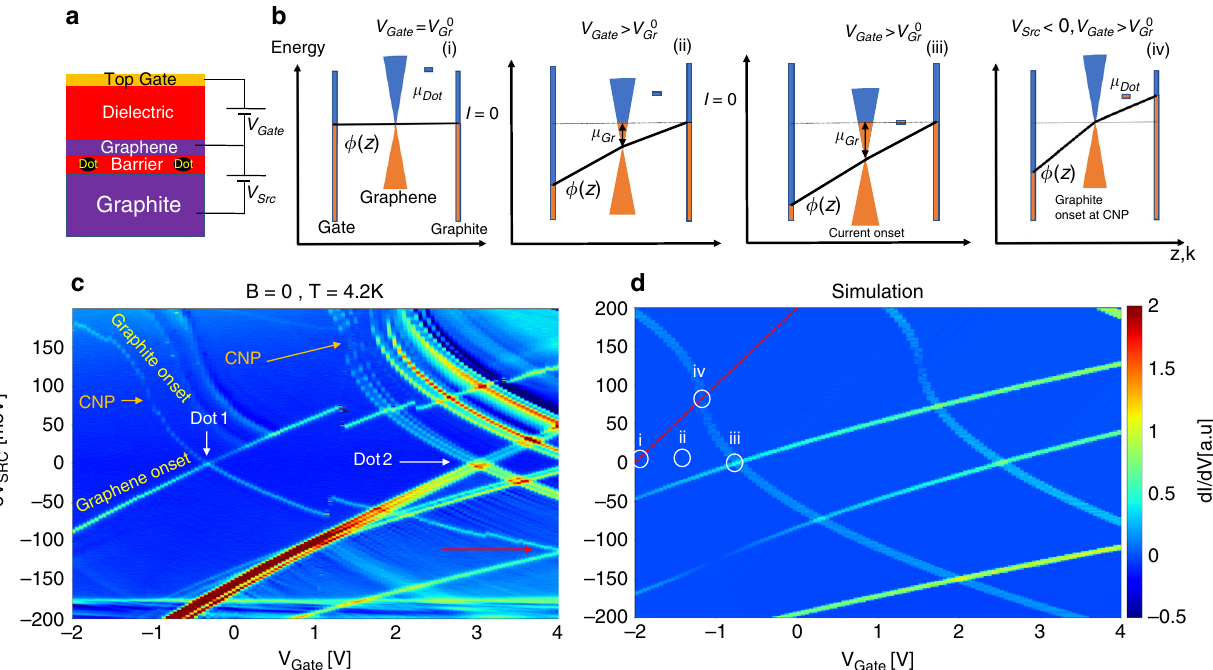
Fig. 1 Tunneling through quantum dots. a A schematic illustration of the device. The quantum dots are present within the hBN layer between graphite and graphene. b The energy diagram illustrating the change of the electrostatic potential ϕ ( z ) upon application of V Gate and V Src and its effect on the dot potential μ Dot . The horizontal axis marks both k (momentum of the graphene dispersion) and z (the position coordinate). c d I /d V vs. − e V S rc and V Gate at T = 4.2 K. Transport signatures of distinct quantum dots, “ Dot 1 ” and “ Dot 2 ” are marked. CNP is marked by an arrow for both dots. Graphite (source) onset and graphene (drain) onset lines are labeled for Dot 1 while the red arrow signals the charging energy of Dot 1. d Simulated d I /d V for the capacitive model described in the text, assuming two dots where μ 0 = 40 meV for Dot 1 and μ 0 = 67 meV for Dot 2. The positions corresponding to diagrams (i) – (iv) in b are marked and so is an equal density line, corresponding to n G r = 0 near Dot 1 (red dashed